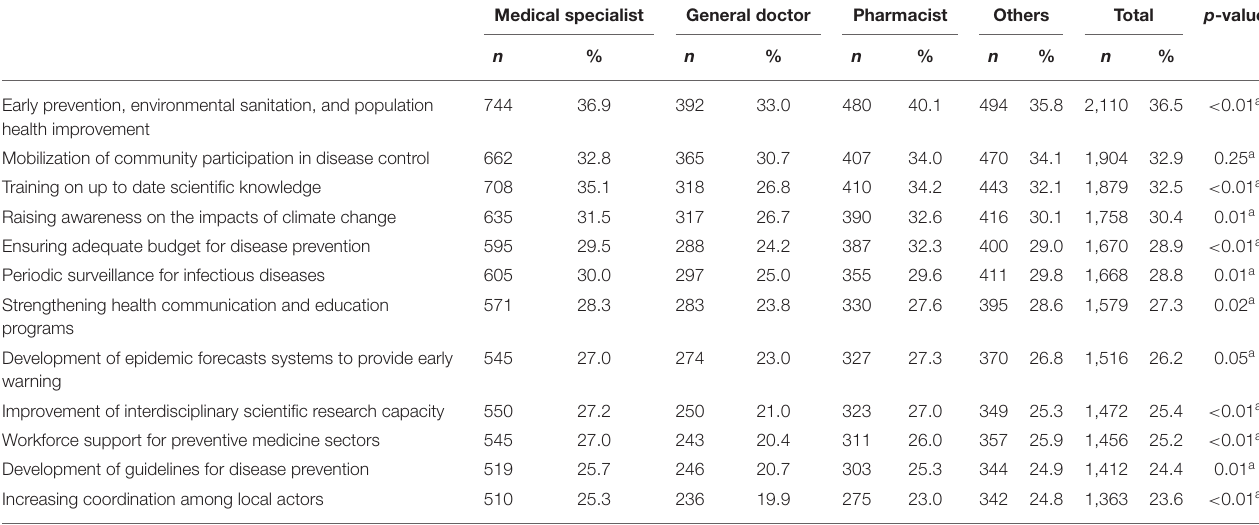
TABLE 3 | Agreement on the importance of local hygiene and disease prevention measures.